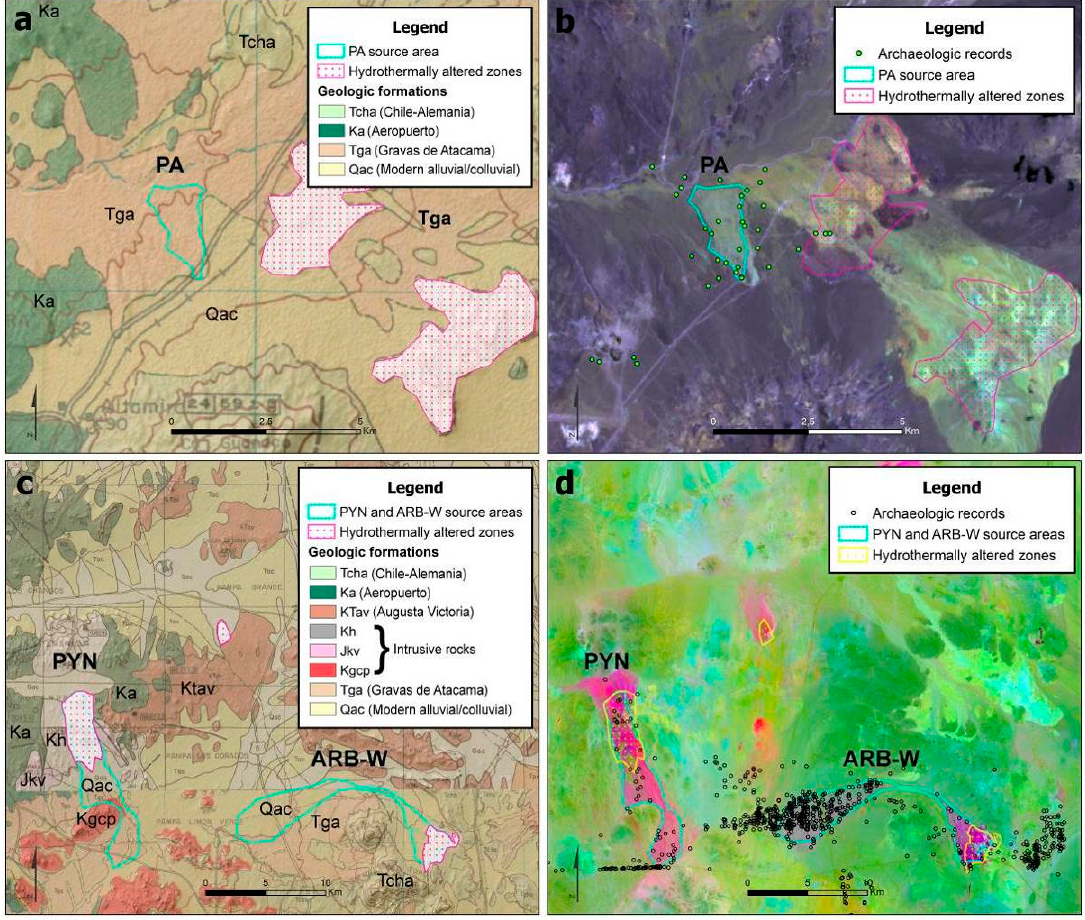
Figure 8. Comparison of 1:250,000 geological maps ( a , c ) [80,81] and processed satellite images: ( b ) 7-6-2 (RGB), and ( d ) PCs 5-4-2 (RGB), showing the geographical setting of chert source areas: ( a , b ) Pampa Altamira; ( c , d ) Pampa Yolanda Norte and Arbiodo West.